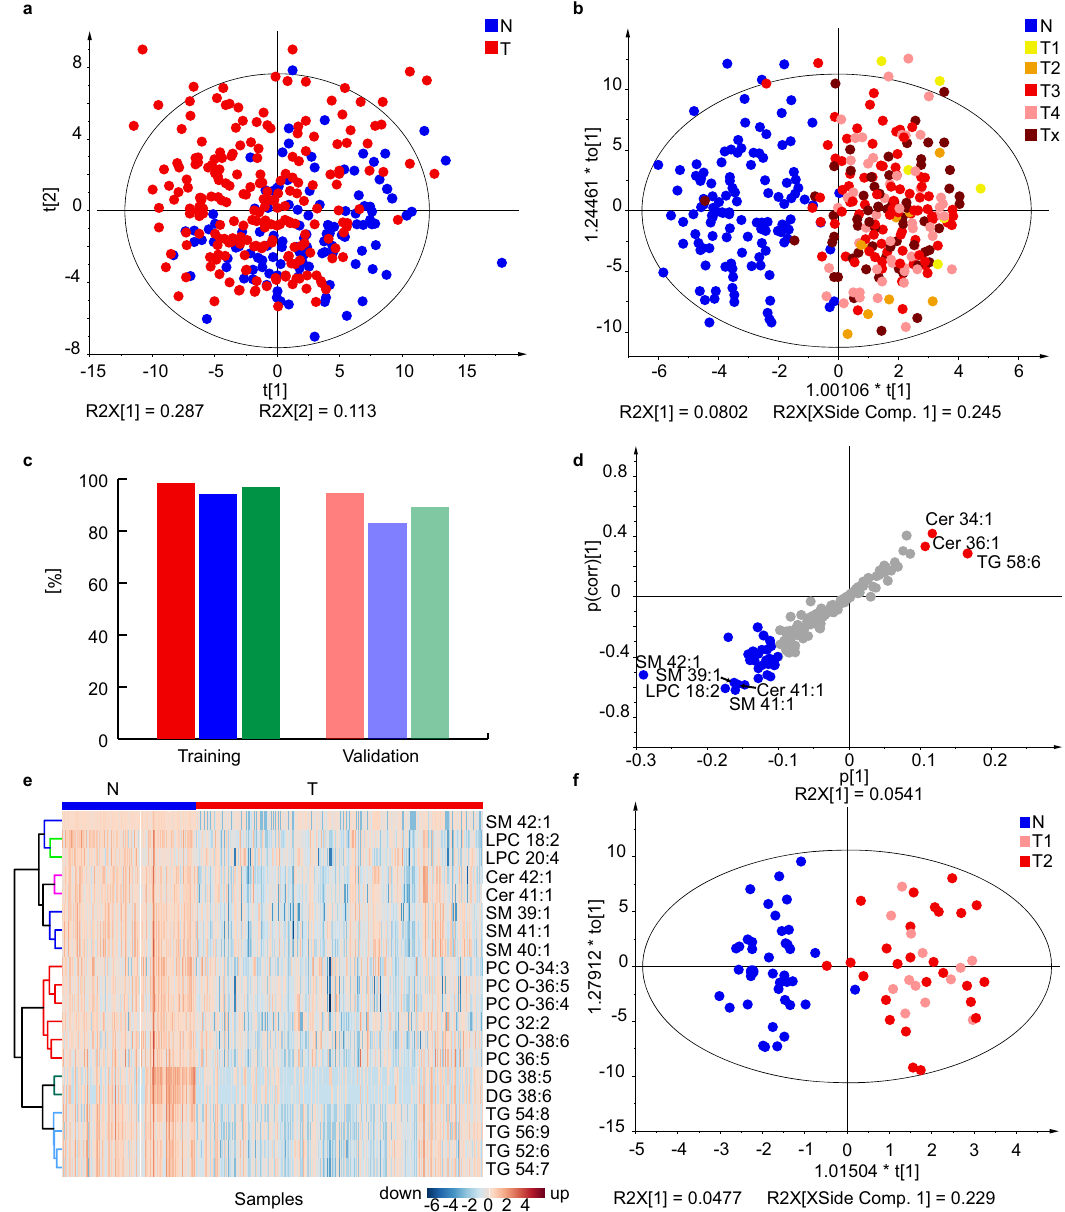
Fig. 5 Results for the lipidomic pro fi ling of male serum samples from PDAC patients (T) and healthy controls (N) in Phase III. a PCA for the training set (219 T + 122 N). b OPLS-DA for the training set (219 T + 122 N). Individual samples are colored according to tumor (T) stage: T1 - yellow, T2 - orange, T3 - red, T4 - rose, and Tx - brown (information about the stage is not available). c Sensitivity (red), speci fi city (blue), and accuracy (green) for the training (219 T + 122 N) and validation (56 T + 6 N) sets. d S-plot for the training set with the annotation of most upregulated (red) and downregulated (blue) lipid species. e Heat map for both training and validation sets (275 T + 128 N) using the lipid species concentrations [nmol/mL]. f OPLS-DA for early stages T1 + T2, age aligned (mean age is 65 ± 4 years for N and 67 ± 4 for T), and number aligned (39 T + 39 N). This graph includes both genders. Source data are provided as a Source Data fi The in fl uence of cancer treatment on the lipidomic pro fi ling PDAC 32 . The ROC curves showed the best performance for the was investigated for a small subgroup within the sample set combination of lipidomic pro fi ling and CA 19-9, followed by the with blood collection before and several days after surgery. lipidomic pro fi ling, the CancerSeek method, and fi nally the determination of only CA 19-9 (Fig. 7g). The comparison of sensitivity and speci fi city values for various methods (Fig. 7h) showed that CA 19-9 and CancerSeek yielded higher speci fi city than sensitivity values 32 . The opposite was observed for lipidomic pro fi ling yielding higher sensitivity than speci fi city values. The combination of lipidomic pro fi ling and CA 19-9 resulted in increased speci fi city. control samples (Figs. 5d and 6d). Furthermore, some patients